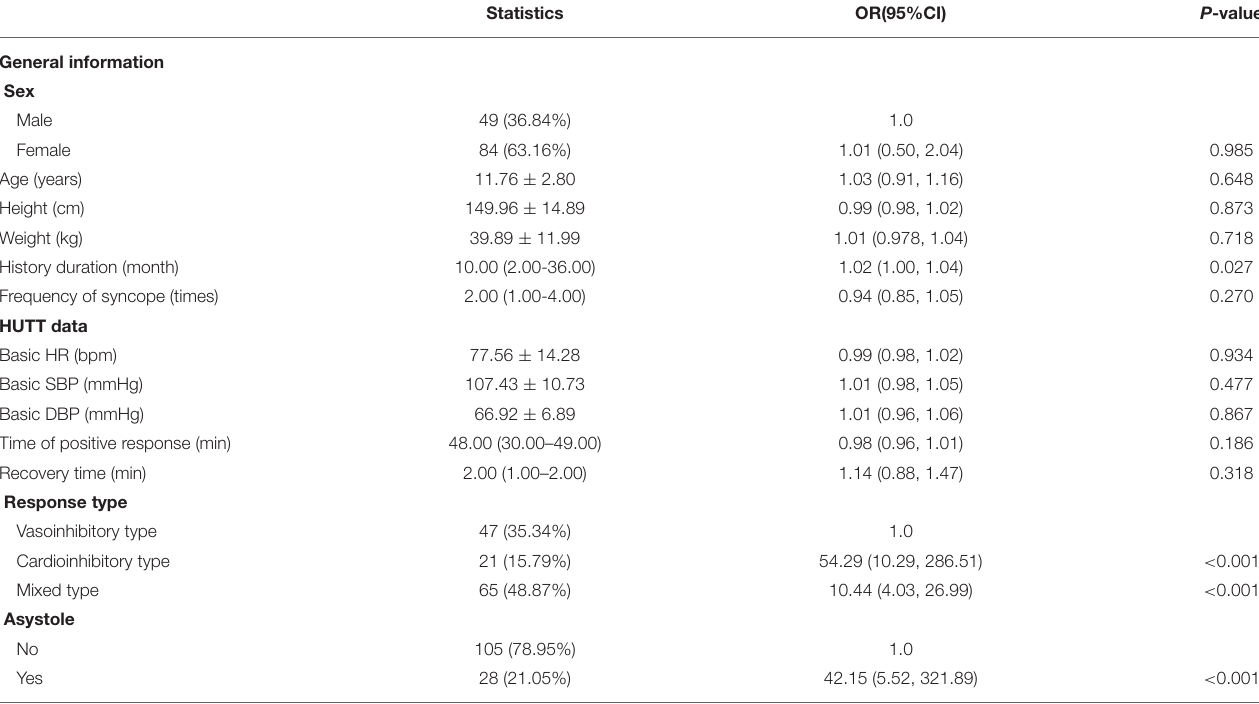
TABLE 2 | Univariate analysis for seizure-like activities [ n = 133, Mean ± SD, M (Q1–Q3), n (%)].